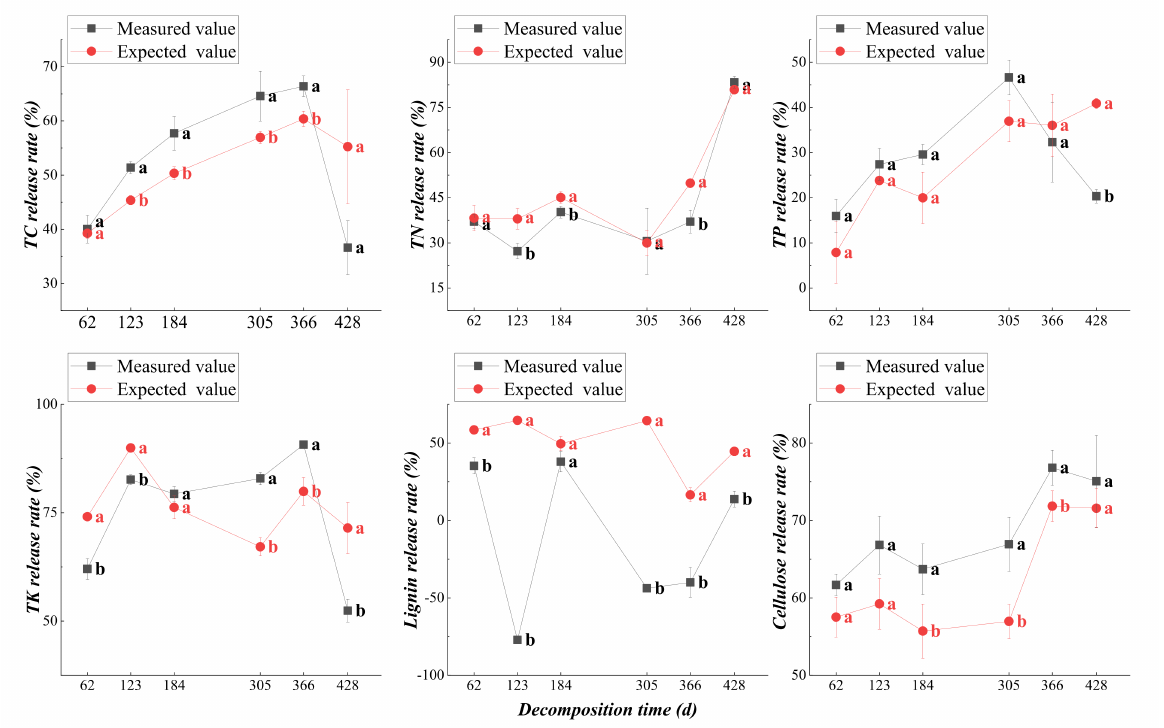
Figure 11. Measured and expected values of the nutrient release rate during CPM plant residue decomposition. Note: a, b—differences between expected value and measured value in the same decomposition period ( p <